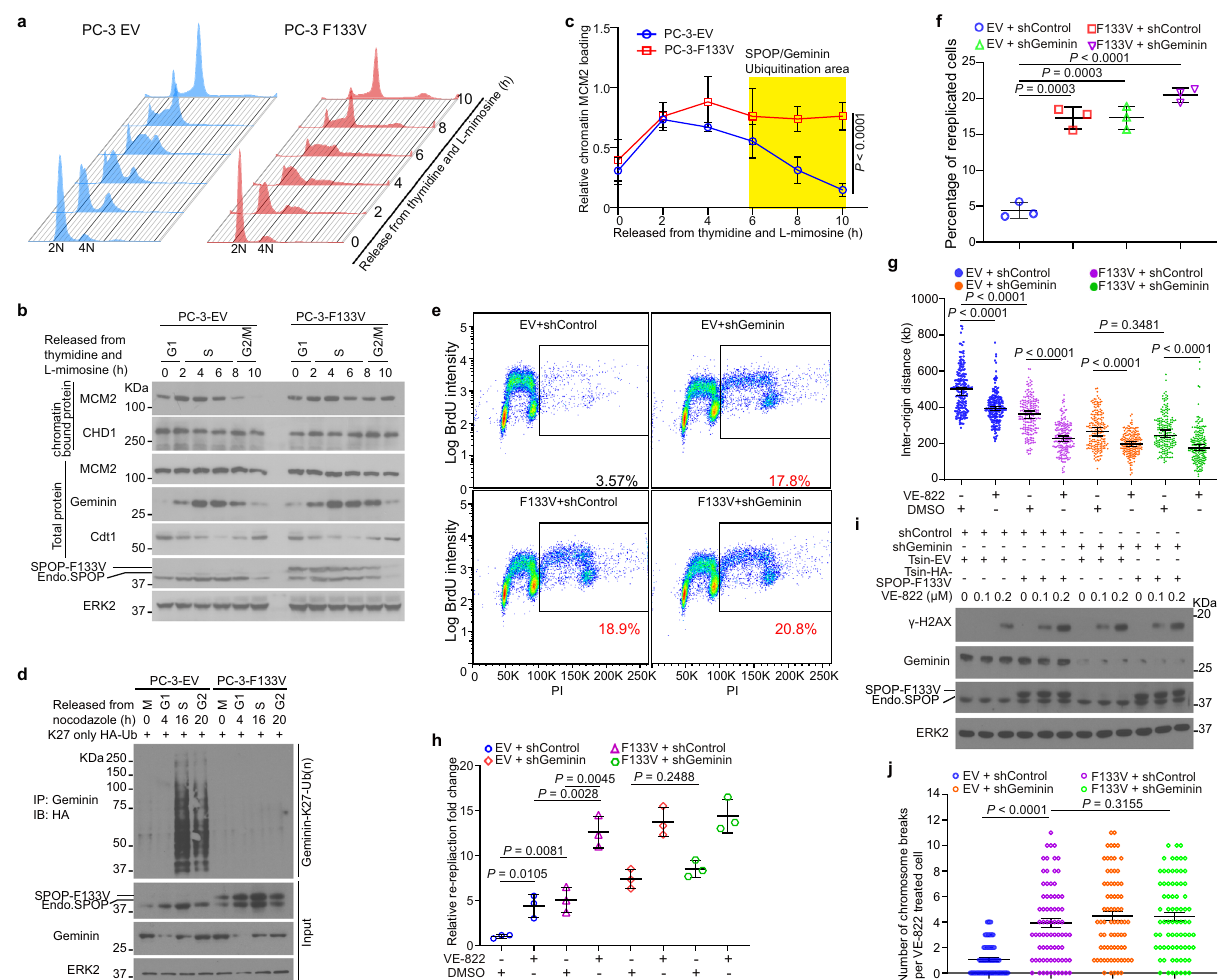
Fig. 5 Prostate cancer-derived SPOP mutants increase replication origin fi ring, re-replication, and genome instability, especially upon ATR inhibition. a PC-3 cells stably expressing empty vector (EV) and SPOP-F133V mutant were synchronized by thymidine and L-mimosine double blockade. Cells were released and harvested at the indicated time points for FACS-based cell cycle analysis. b PC-3 cells expressing EV and SPOP F133V were synchronized as in ( a ) and harvested for WB. Similar results were obtained in three independent experiments. c Protein bands for chromatin-associated MCM2 from the experiment shown in ( b ) and the other two repeats were quanti fi ed using ImageJ and normalized to total MCM2 protein level. Data are presented as the mean ± SD ( n = 3). The P value was calculated by two-way ANOVA analysis. d EV- and F133V-expressing PC-3 cells transfected with HA-Ub-K27-only were synchronized with nocodazole and released at different time points and harvested for IP and WB. e , f PC-3 cells infected with lentivirus expressing EV or SPOP F133V in combination with control or Geminin-speci fi c shRNAs. Cells were pulse-labeled with 30 μ M BrdU for 30 min and harvested for FACS analysis ( e ) and quantitative data are shown in ( f ). Data are shown as the mean ± SD of three independent experiments. Two-tailed unpaired Student ’ s t - test. g PC-3 cells infected with lentivirus expressing empty vector (EV) or F133V in combination with control or Geminin-speci fi c shRNAs were treated with DMSO or 100 nM VE-822 for 8 h followed by DNA fi ber assay. Inter-origin distances between 200 replication fi ring origins were measured ( n = 200). Data are shown as the mean ± SD of three independent experiments. Two-tailed unpaired Student ’ s t -test. h Stable PC-3 cells as indicated were treated with DMSO or 100 nM VE-822 for 8 h followed by DNA fi ber assay. DNA re-replication was quanti fi ed from 200 DNA tracks and relative re-replication fold changes are presented. Data are shown as the mean ± SD of three independent experiments ( n = 3). Two-tailed unpaired Student ’ s t -test. i PC-3 cells infected with lentivirus expressing the indicated shRNAs or EV or SPOP F133V were treated with DMSO or increased doses of VE-822 for 24 h and harvested for WB with indicated antibodies. j Stable PC-3 cells as indicated were treated with VE-822 (100 nM) for 24 h. Cells were harvested for karyotyping. Quanti fi cation of chromosome breaks per cell are shown. More than 70 metaphases from four biological replicates were counted. Data are mean ± SEM. Two-tailed unpaired Student ’ s t -test. Source data are provided in this paper or Mendeley database (10.17632/8n7xt5rkhc.1). Similar results for ( b ), ( d ), and ( i ) panels were obtained in two independent